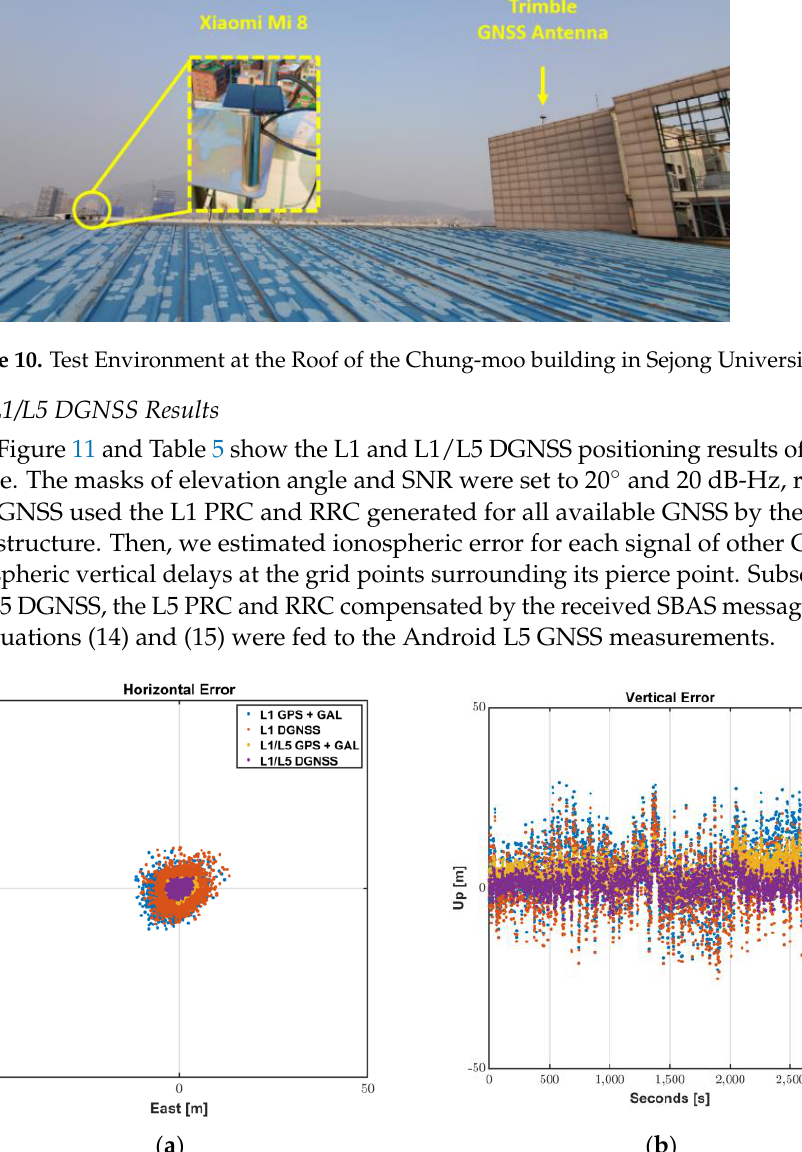
( b ) Figure 9. Noise level of measurements: ( a ) 2nd order time derivative of Carrier-phase; ( b ) 1st order time derivative of Doppler. Sharp jumps due to unexpected cycle-slips of the phase shown in the green dashed line box in Figure 9 can cause filter initialization and divergence, but this can be prevented for Doppler without cycle slip. In addition, as mentioned in Section 2.3, not all smartphones support carrier-phase measurements, but all Doppler measurements are supported. Therefore, a practical filtering method to smart devices L1/L5 code measure- ments should be performed with Doppler rather than phase difference. 4. Smartphone Positioning Algorithm Implementation and Field Test Results 4.1. Configuration of Field Test